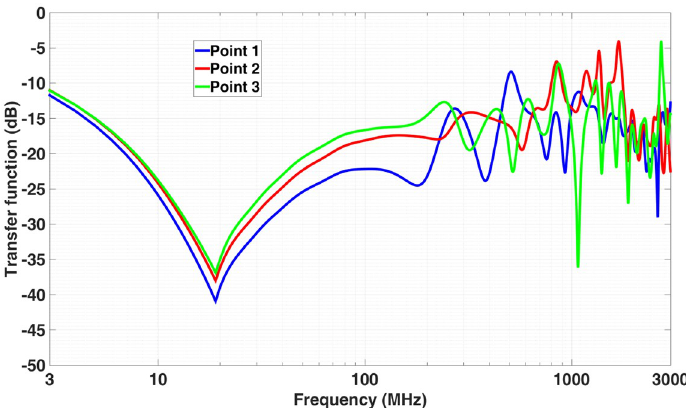
Fig 9. Transfer function at 3 different points inside the skull as a function of the frequency (see Fig 8 for their location).